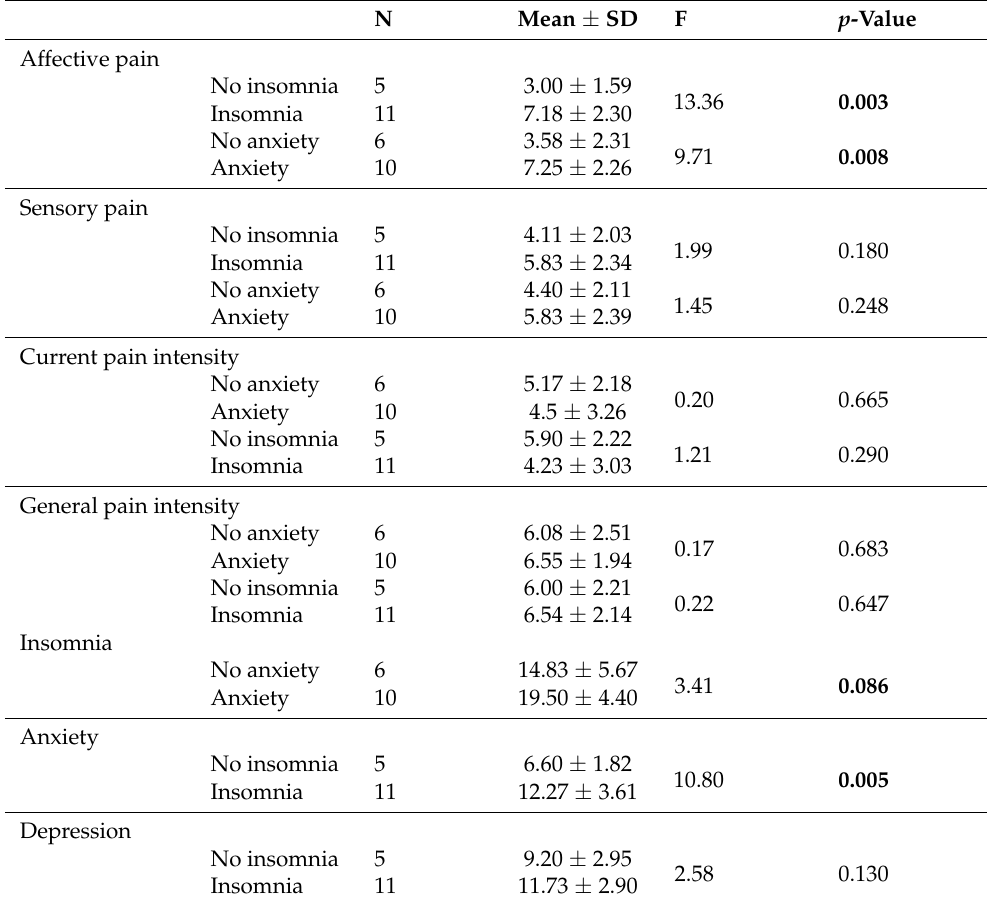
Table 3. Univariate comparisons of pain, sleep, and mood scores in FM patients between pathological and nonpathological